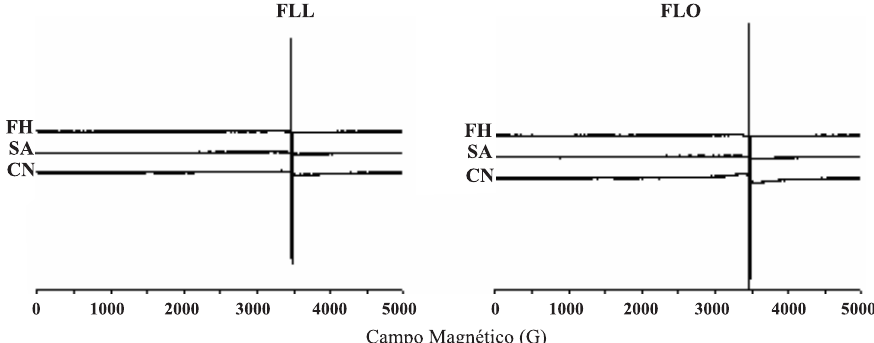
Figura 4. Espectros de Ressonância Paramagnética Eletrônica (EPR) da fração leve livre (FLL) e fração leve oclusa (FLO) da matéria orgânica de um Argissolo Vermelho submetido a sistemas de uso na camada de 0,000 a 0,025 m. FH: Floresta homogênea de eucalipto; AS: Sistema agrossilvipastoril na entrelinha; e CN: Campo